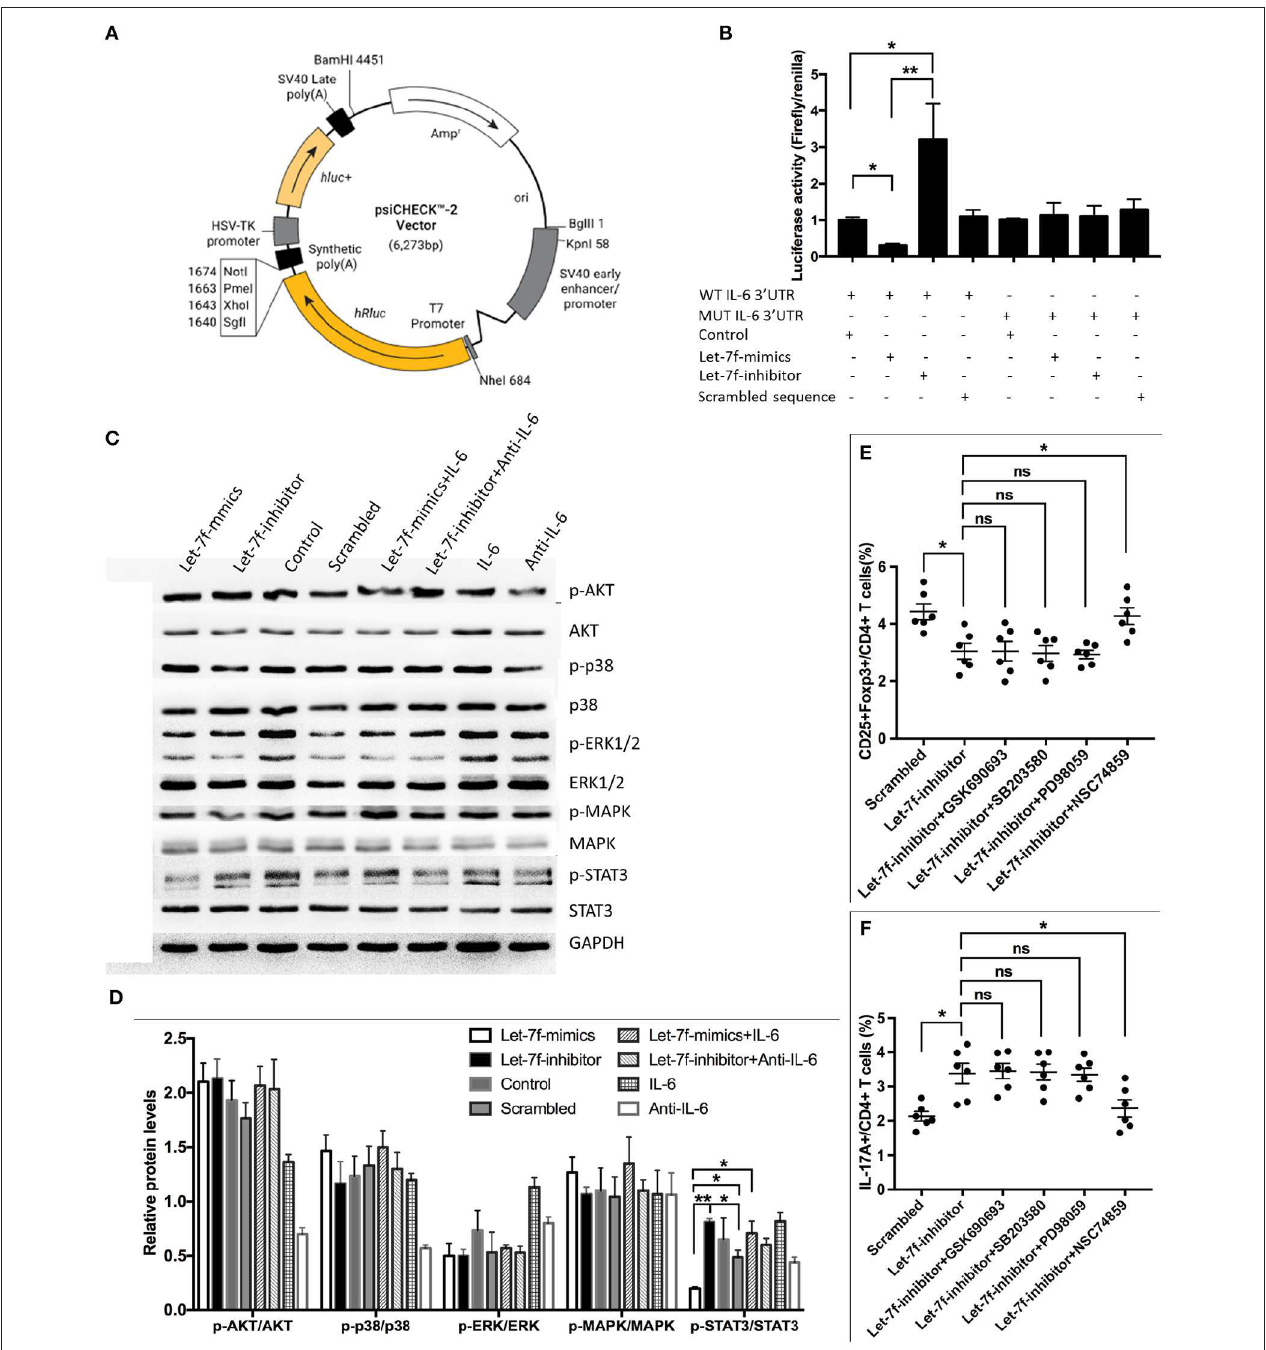
FIGURE 5 | IL-6 is a direct target of let-7f. (A) Construction of TGF- β 1’-UTR luciferase vector. (B) IL-6 response element reporter assay with let-7f precursor or let-7f inhibitors. IL-6 3 ′ -UTR is involved in let-7f regulated gene expression. (C,D) The effect of let-7f and IL-6 on AKT, p38, ERK, MAPK, and STAT3 pathway in BM-MSCs. (E,F) The role of AKT inhibitor (GSK690693), p38/MAPK inhibitor (SB203580), and STAT3 inhi bitor (NSC74859) in immunoregulatory effect of let-7f related oligonucleotide transfected BM-MSCs on Treg and Th17 cells. All data are mean ± SEM. n = 6, * P < 0.05, ** P < 0.01.